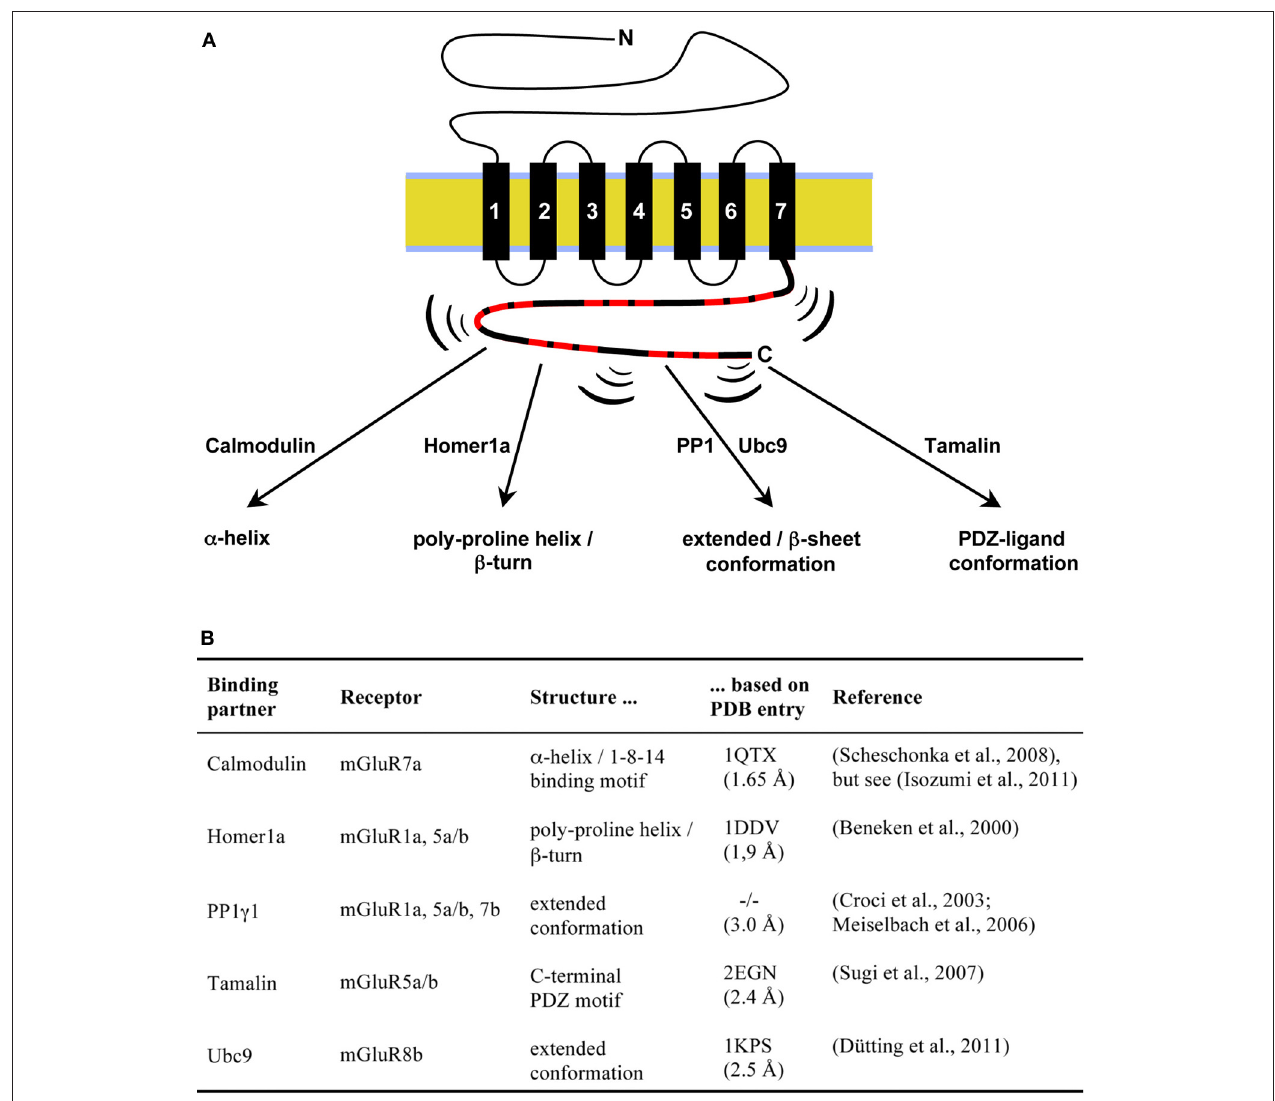
FIGURE 2 | Inducible structure of mGluR C-terminal sequences in contact with interacting proteins. (A) Intrinsically disordered amino acid sequences within mGluR C-termini (symbolized by brackets) adopt defined confirmations upon interaction with the indicated proteins. (B) Overview of